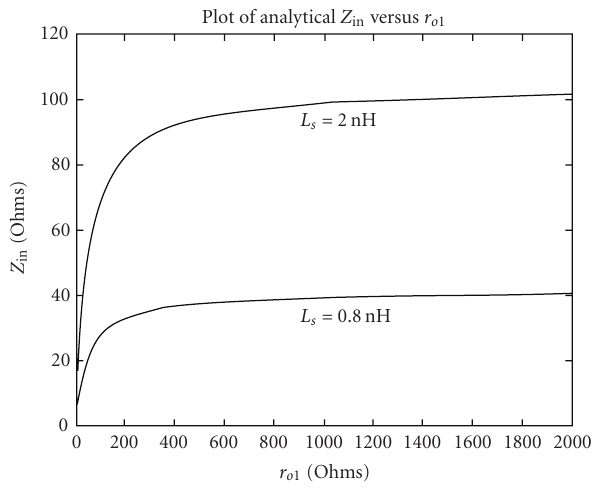
Figure 2: Variation of the analytical Z in with finite output impedance ( r o 1 ) of M1 fornanometric CMOS.